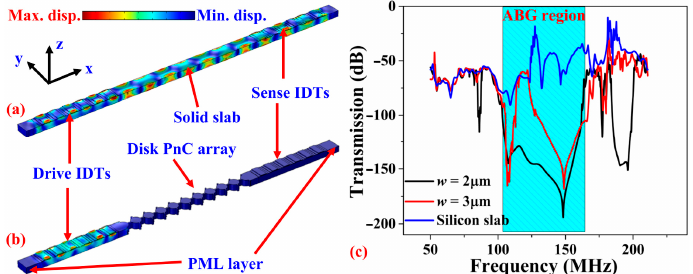
Figure 2. FE simulations with periodic boundary conditions applied along the y-axis—Displacement profiles of the ( a ) reference delay line having solid slab as the transmission medium and ( b ) delay line with PnCs (with inter-cell link width w = 3 μ m) as the transmission medium. ( c ) Simulated transmission S 21 of the three delay lines showing the existence of the bandgap associated with the solid disk PnC observed through significant drops in transmission within a wide stop band.